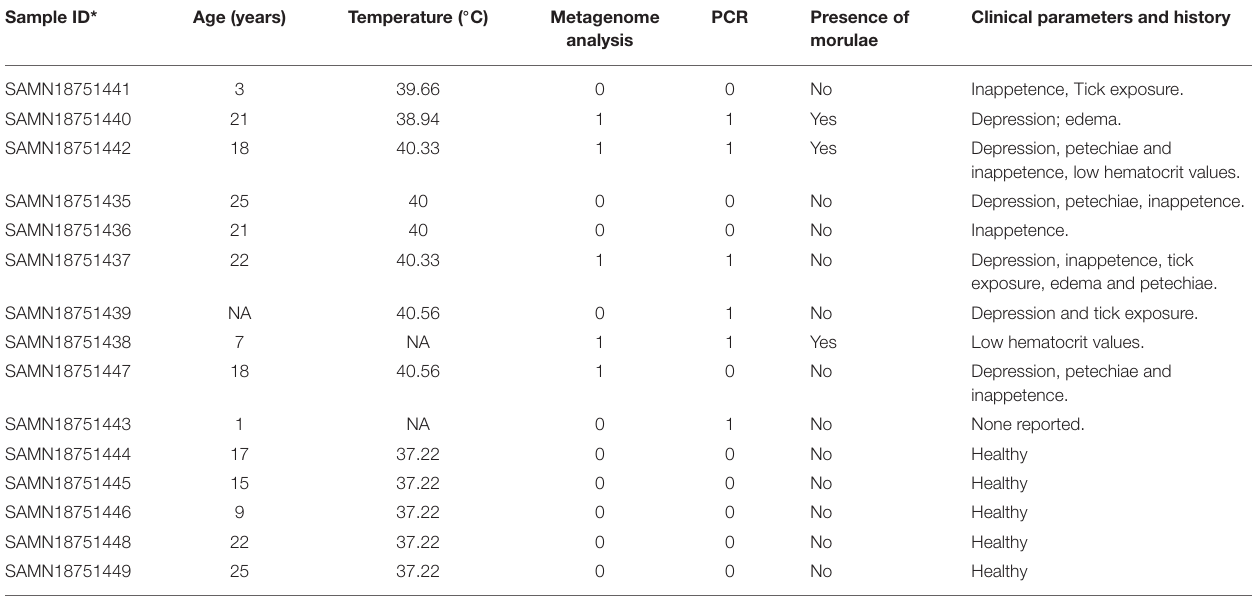
TABLE 1 | Demographic, clinical and laboratory analyses for horses included in the study. Sample ID*